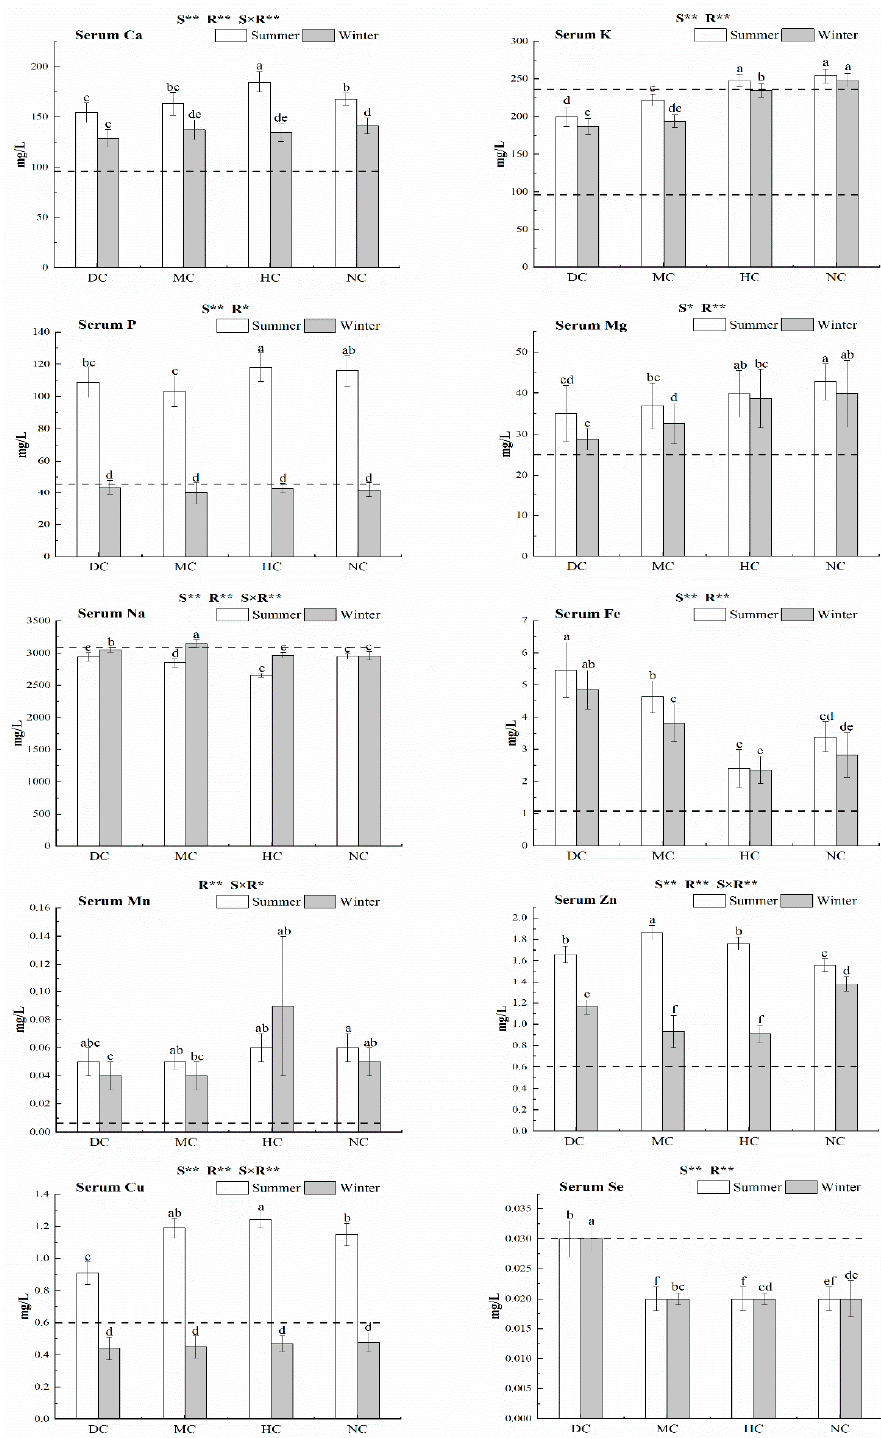
Figure 3. The separate serum Ca, K, P, Mg, Na, Fe, Mn, Zn, Cu, and Se levels of yak required during summer and winter. DC, Datong County; MC, Maqu County; HC, Hongyuan County; NC, Naqu County. R: region; S: season; S × R: season × region; ns: non-significance, *: significance at 0.05 level, **: significance at 0.01 level. One or two dashed horizontal lines across each graph, indicating the marginal ranges. Serum Ca (90 mg / L), Serum K (97.5–234.0 mg / L), Serum P (46.5 mg / L), Serum Mg (25.0 mg / L), Serum Na (3105.0 mg / L), Serum Fe (1.1 mg / L), Serum Mn (0.006 mg / L), Serum Zn (0.6 mg / L), Serum Cu (0.6 mg / L), and Serum Se (0.03 mg / L)